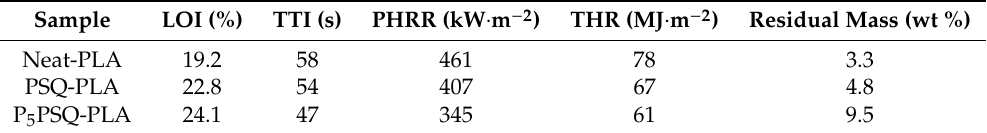
Table 2. LOI value and CCT data for neat PLA and its flame retardant composites.